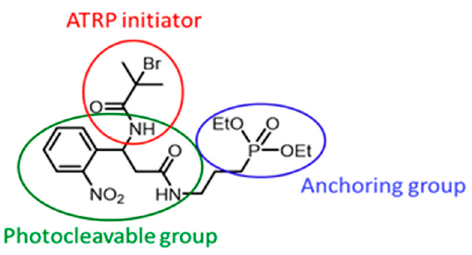
Figure 2. Photocleavable initiator (PCI) chemical structure.